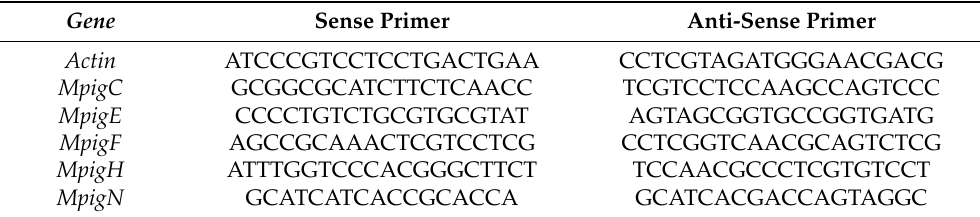
Table 1. Primers for qRT-PCR in this